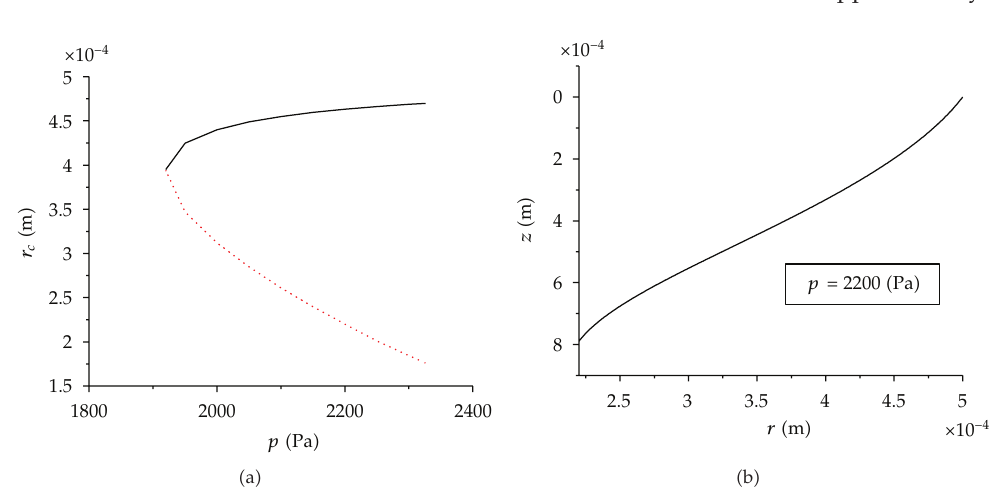
(cid:8) 1 . 4rad, n (cid:8) 1 . 1 , n (cid:2) (cid:8) 1 . 01; (cid:6) b (cid:7) The convex-concave meridian Figure 6: (cid:6) a (cid:7) The function r c (cid:6) p (cid:7) for α c (cid:8) α 2 c curve for p (cid:8) 2200Pa, suitable to grow microfiber with radius 2 . 2 × 10 − 4 m. (cid:8) 4 . 632 × 10 − 4 m and r 2 (cid:8) 2 . 2 × 10 − 4 m, respectively. If the thermal field is fixed such that at r 1 c c (cid:8) 1 . 68 × 10 − 4 m, then the fiber the solidification conditions are satisfied at the level z (cid:8) h 1 c (cid:8) 4 . 632 × 10 − 4 m. When the thermal field is fixed such that the solidification radius will be r 1 c (cid:8) 7 × 10 − 4 m, then the fiber radius will be r 2 conditions are satisfied at the level z (cid:8) h 2 c 2 . 2 × 10 − 4